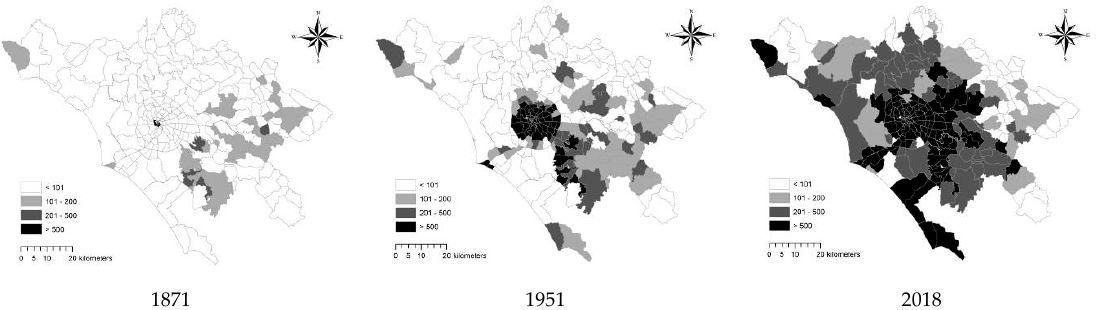
Figure 4. Demographic density (inhabitants / km 2 ) in Rome’s metropolitan area, 1871–2018.